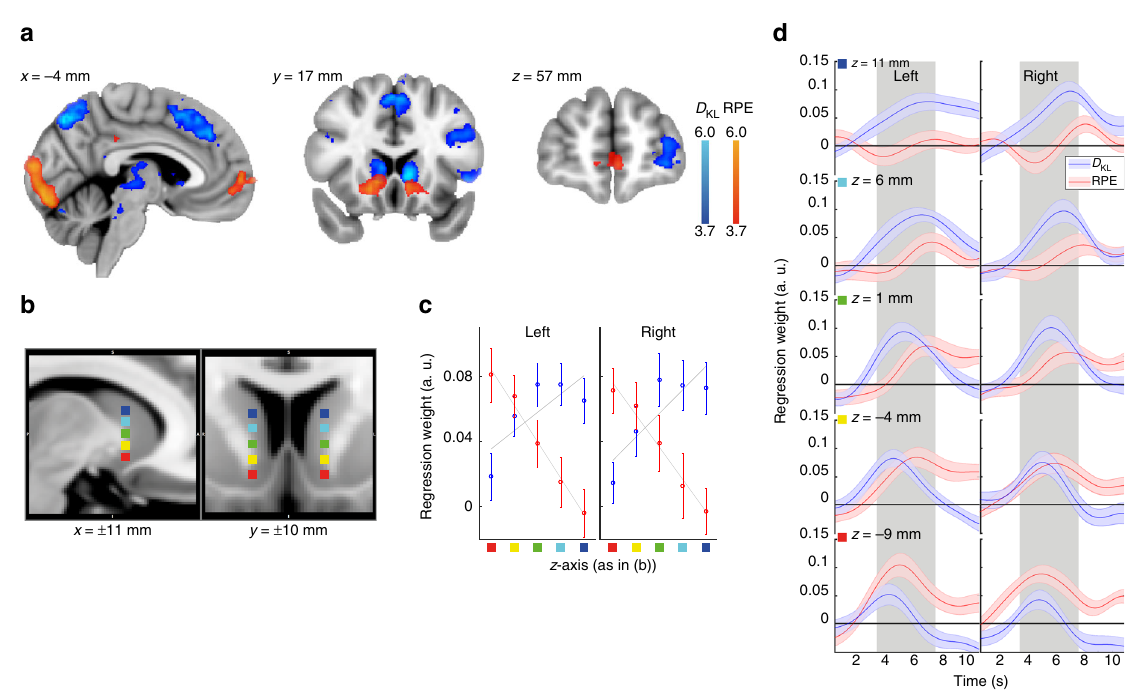
Fig. 3 Effects of model-based inference and model-free experience. a Shows positive covariation with Bayesian model update ( D KL , blue) and reward prediction- error (RPE, red). D KL was associated with activity in the intraparietal sulcus (IPS; peak Montreal Neurological Institute coordinates − 14, − 70, 54mm, peak z - score = 6.00), posterior mesial frontal cortex (pMFC; 0, 27, 50mm, z -score = 5.40), left dorsolateral prefrontal cortex (dlPFC; − 45, 25, 27mm, z -score = 6.03), and left frontopolar cortex (FPC; − 35, 60, 6mm, z -score 5.07). In addition, the dorsal striatum (caudate nucleus) covaried with D KL (right 9, 17, 6mm, z -score = 5.07; left − 9, 16, 2mm, z = 4.94), whereas the ventral striatum covaried with RPE (right 14, 9, − 8mm, z = 5.51; left − 9, 13, − 8mm, z -score = 5.00), for which an activations can be found in Supplementary Table 1. Spatial gradient analysis comparing functional main effects against anatomical location along the bilateral z-axis from ventral to dorsal striatum ( x = 11, y ± 10mm) in 5mm steps (indicated by the colour-marks in b that correspond to the z -axis in c and plotted in d ). trial (including regressors of no-interest). c displays mean regression-weights from 3 to 7s (grey area) which are compared against the z -axis marked in b in an across-participants regression model. The time-course of this signal is plotted in d . In the left and right striatum, RPE representation gradually decreases along dorsal position (both p < 0.0005), while D KL representation increases (both p < 0.0125), resulting in signi fi cant contrasts within both hemispheres at most